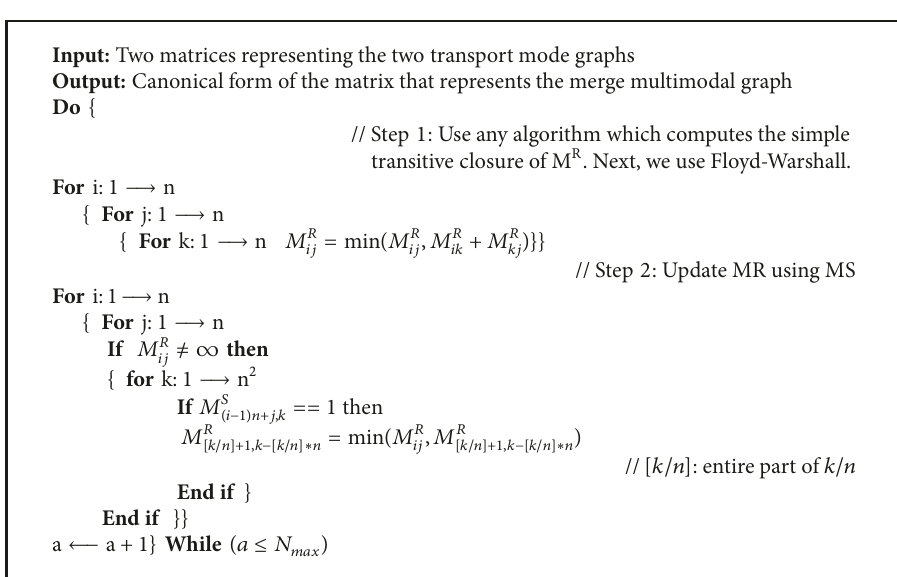
Algorithm 2: Lowest cost in multimodal transport